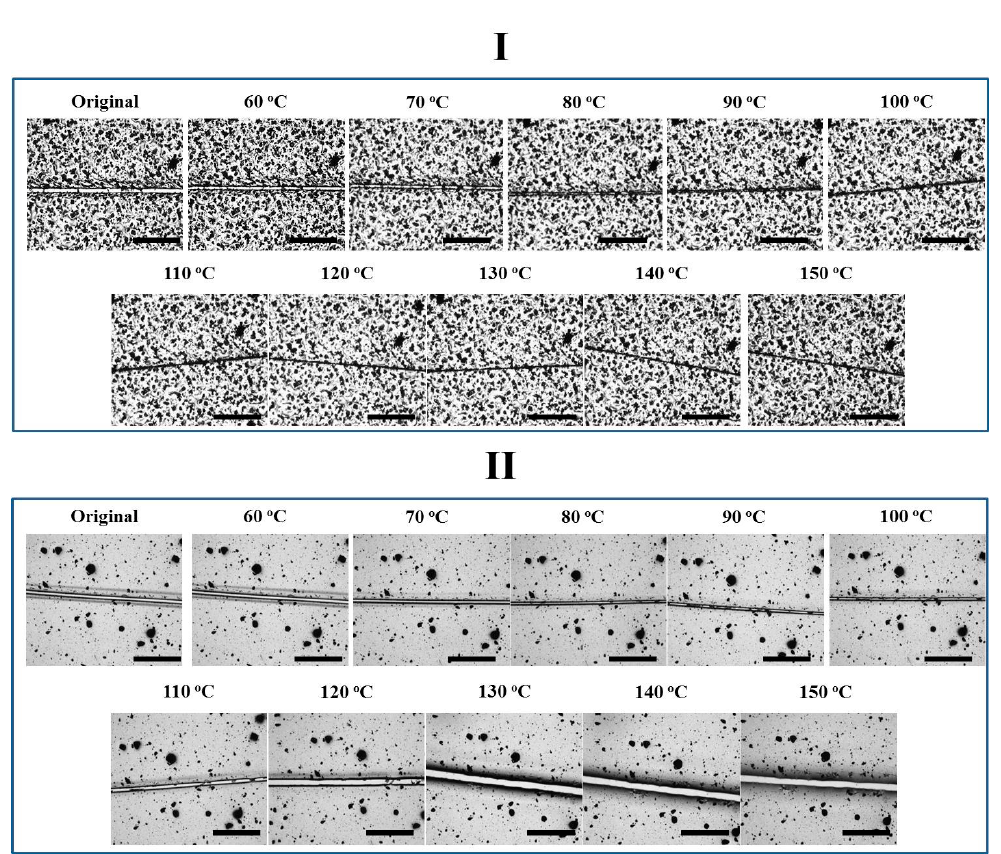
Figure 4. Optical images of the coatings with Networks I–II under thermal treatment of different temperatures for 10 min each. The scale bar stands for 300 μ m.